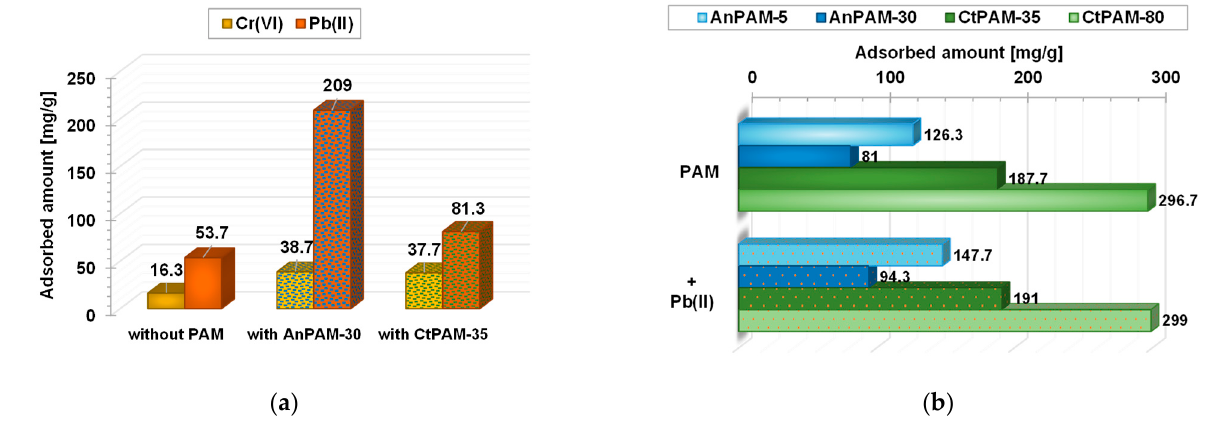
Figure 7. Influence of: ( a ) the presence of ionic polyacrylamide on the adsorbed amounts of heavy metal ions; ( b ) the presence of Pb(II) cations on the adsorbed amount ionic polyacrylamide on the surface of montmorillonite at pH 5, initial concentration of adsorbates is 100 mg/L.